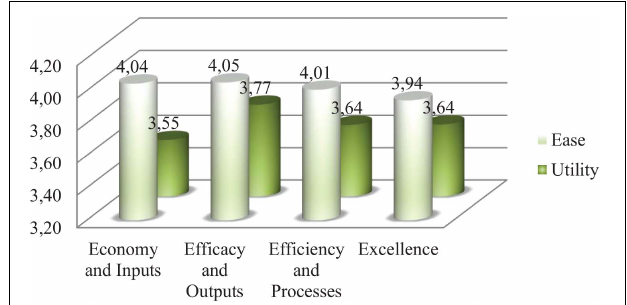
FIGURE 4 | Averages by type of indicator. Source: